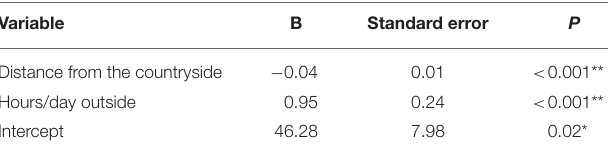
TABLE 2 | Factors affecting the number of prey items brought home by domestic cats in one year, estimated through a general linear